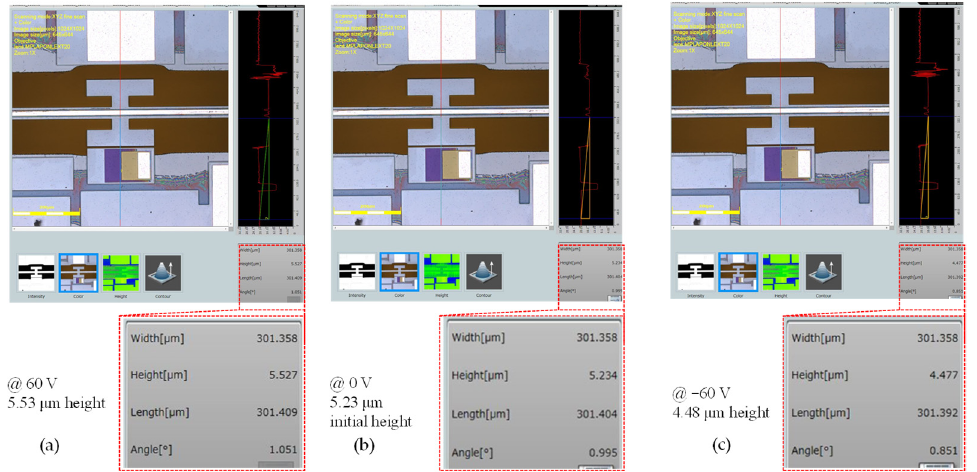
Figure 7. Microscope images showing the height of the platform with respect to the reference point for ( a ) − 60 V, ( b ) at rest, and ( c ) at 60 V. In total, three devices of the same design as the one shown in Figure 1a were tested. The devices were fabricated during the same manufacturing run but are from different dies.